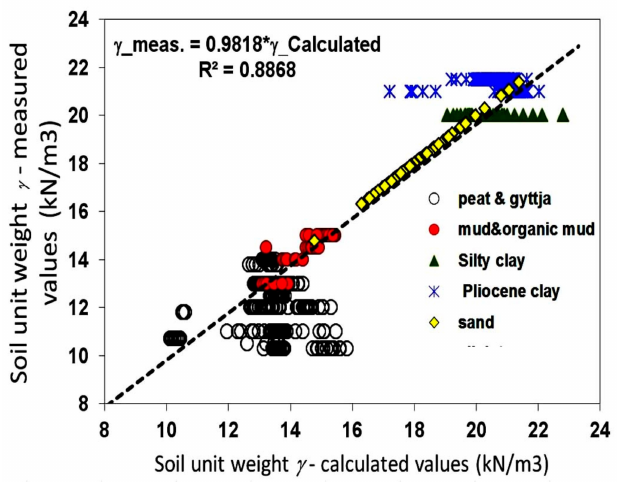
Figure 8. Comparison of soil unit weight obtained from laboratory tests and calculated from the proposed equation (Equation (13)) based on dilatometer test (DMT)